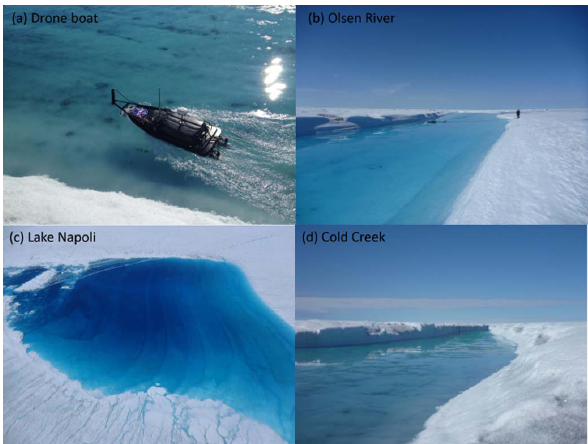
Fig. 2. Photographs of field sites on the surface of the Greenland ice sheet. (a) Remote-controlled drone boat used to collect simul- taneous measurements of depth and reflectance, shown here along the Olsen River. (b) Olsen River, looking downstream toward the ice bar where the channel curves to the right. (c) Overview of Lake Napoli, taken from a helicopter, showing wave-cut platforms associ- ated with former shorelines on the up-glacier (left) side of the lake. (d) Cold Creek, looking